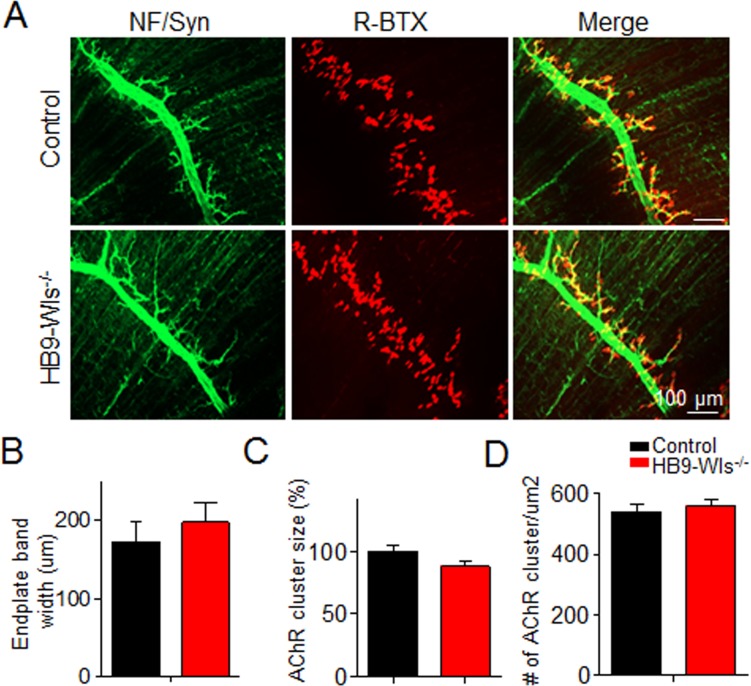
NMJ formation appears grossly normal in HB9-Wls-/- mice.(A) Immunostaining of NMJs in diaphragm of E18.5 control and HB9-Wls-/- embryos with anti-NF and anti-Syn to label motoneuron axons and synaptic vesicles (Green). R-BTX stains postsynaptic AChR (Red). (B) Statistical results of endplate band width of two genotypes. n = 3 mice per group; Unpaired t-test, p>0.05. (C) Statistical results of AChR cluster size. n = 3 mice per group; Unpaired t-test, p>0.05. (D) Statistical results of AChR number. n = 3 mice per group; Unpaired t-test, p>0.05.